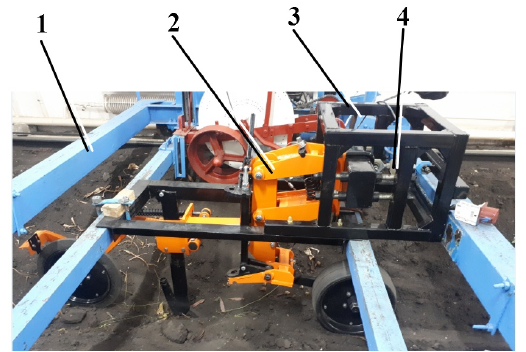
Figure 7. The sowing section on a driven trolley in the laboratory (1 – driven trolley of the tillage bin; 2 –